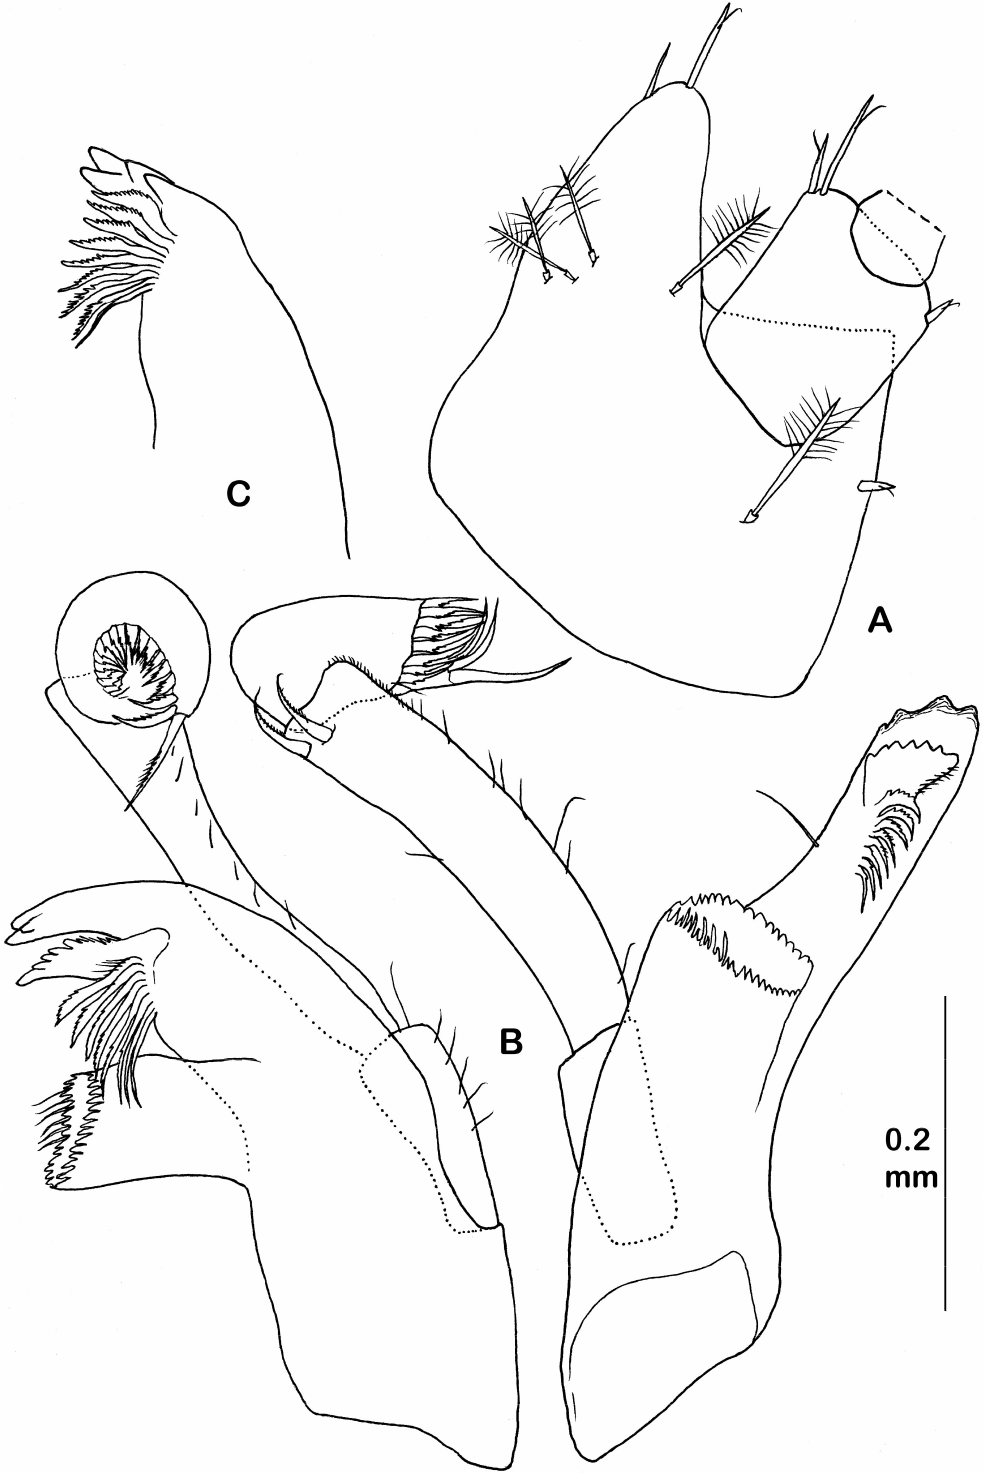
Figure 4. Eurycope producta GO Sars, 1868. Male (ZMH K-45592): ( A ) articles 1, 2 of antenna I; ( B ) left mandible ventral and medial view; ( C ) incisor of right